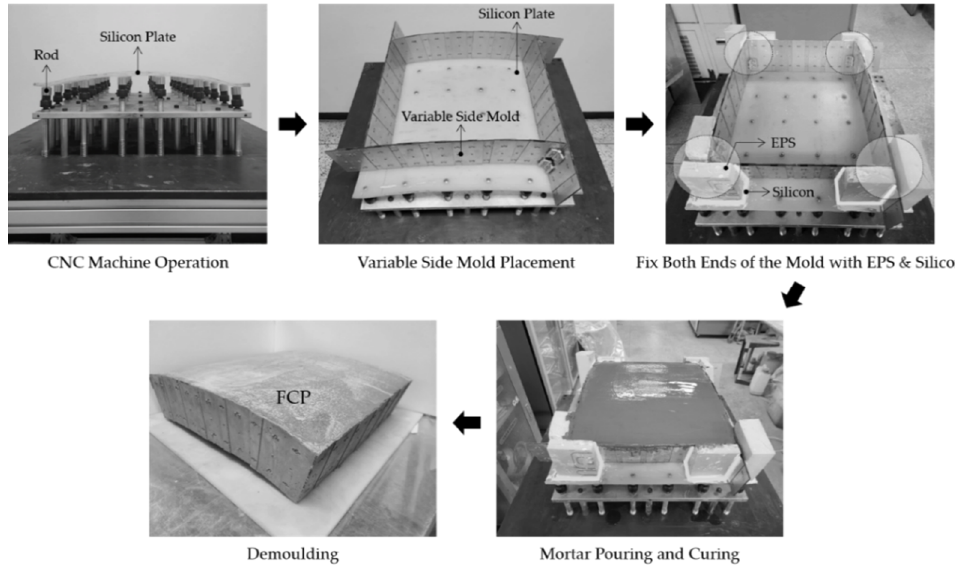
Figure 7. FCP production test process using variable side mold.